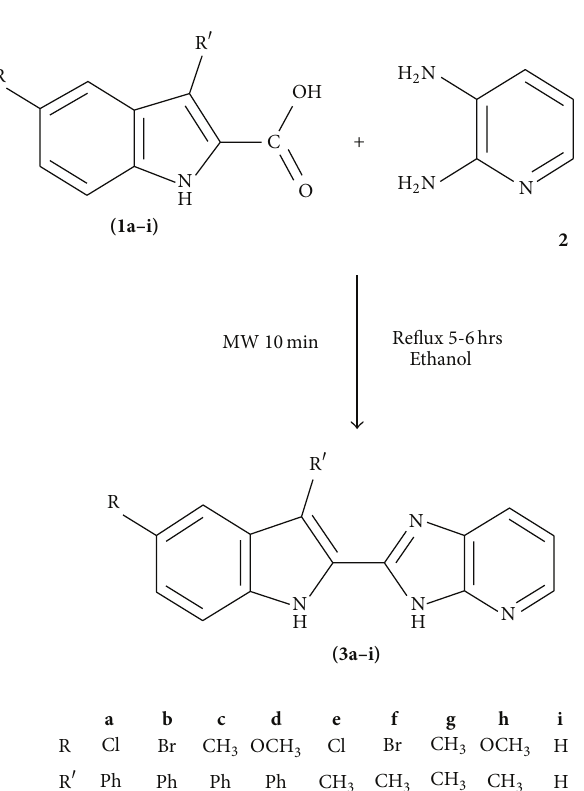
Scheme 1: Schematic representation of the synthesized novel imida- zolopyridinyl indoles 3a–i .